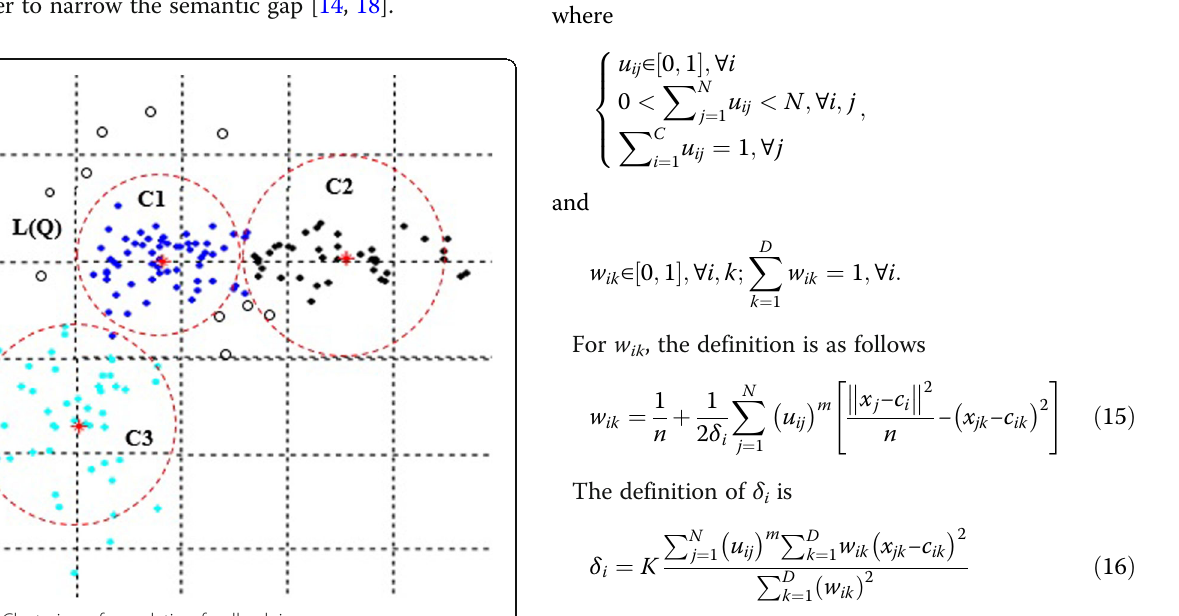
Fig. 4 Clustering of correlation feedback